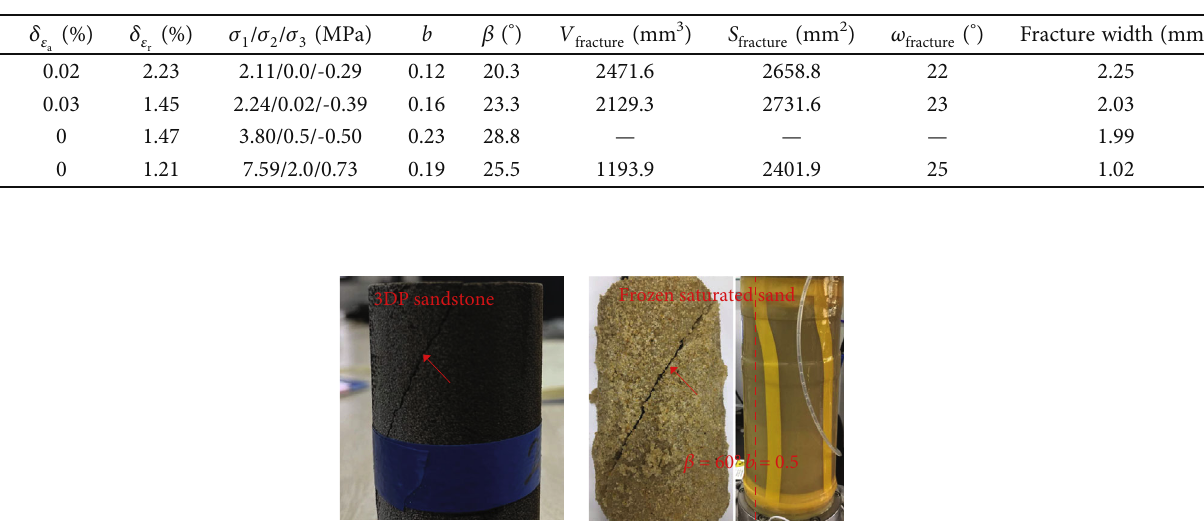
Table 5: Characterization parameters of C-T fractures.